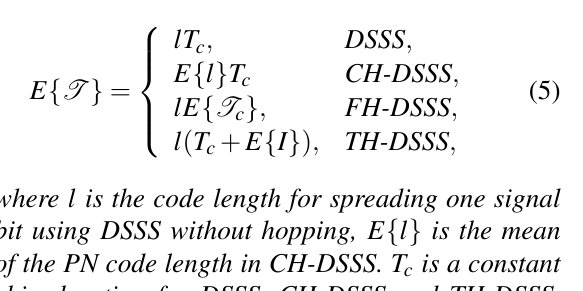
Figure 14: Topology in ns-2